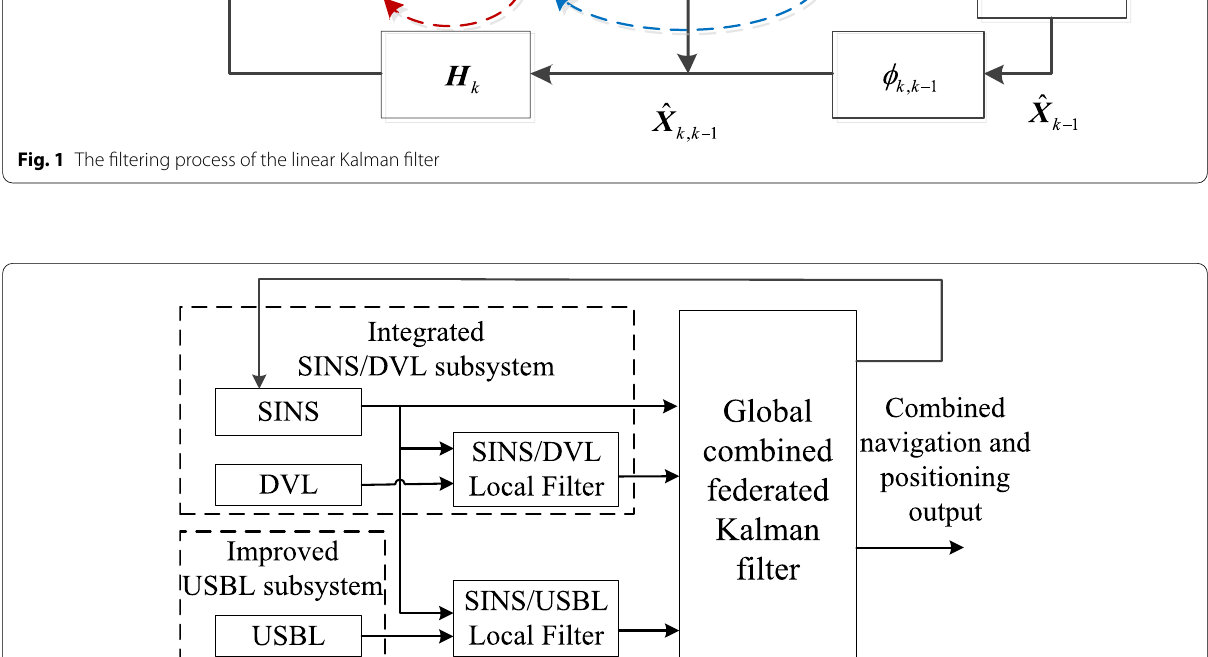
Fig. 2 The framework of the combined navigation and positioning